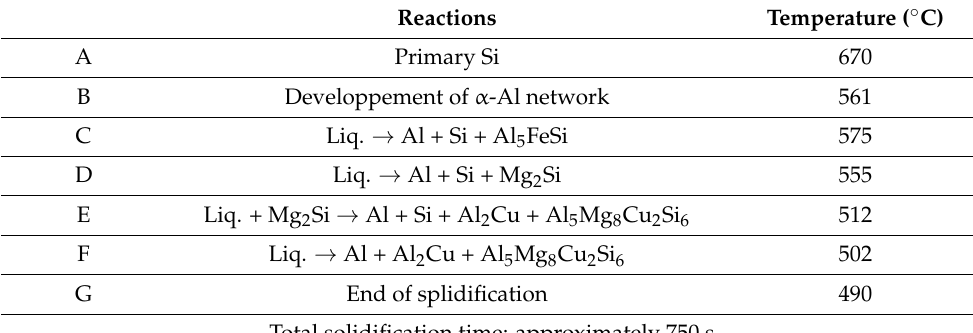
Table 2. Expected reactions in the A390.1